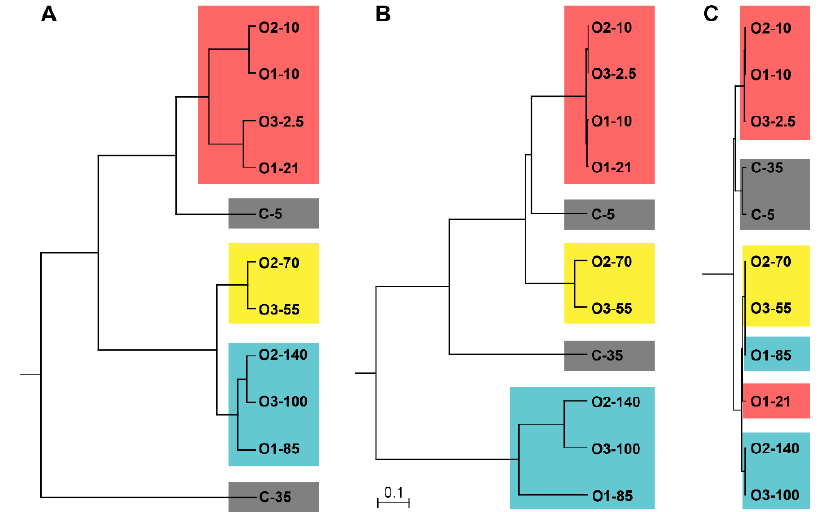
Figure 9. Comparisons of communities at different taxonomic levels across all samples. ( A ) The total bacterial community. ( B ) The order Rhodobacterales. ( C ) The order Pelagibacterales. The comparisons are based on community compositions with 97% identity for definition of OTUs. Communities were compared using the θ yc similarity index. Samples are colored according to water mass: red, UPML; yellow, LPML; blue, PSW; grey, coastal.